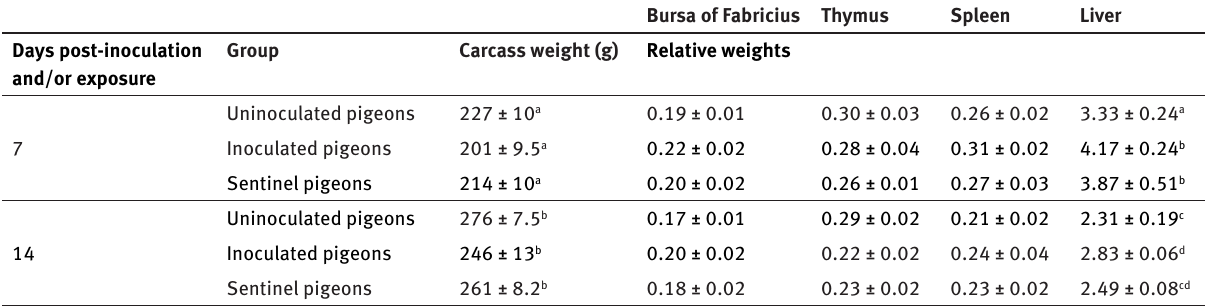
Bursa of Fabricius Thymus Spleen Liver